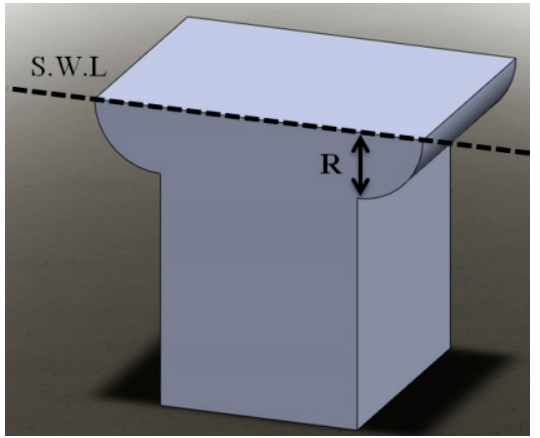
Figure 21. Description of the upside filleted shape.